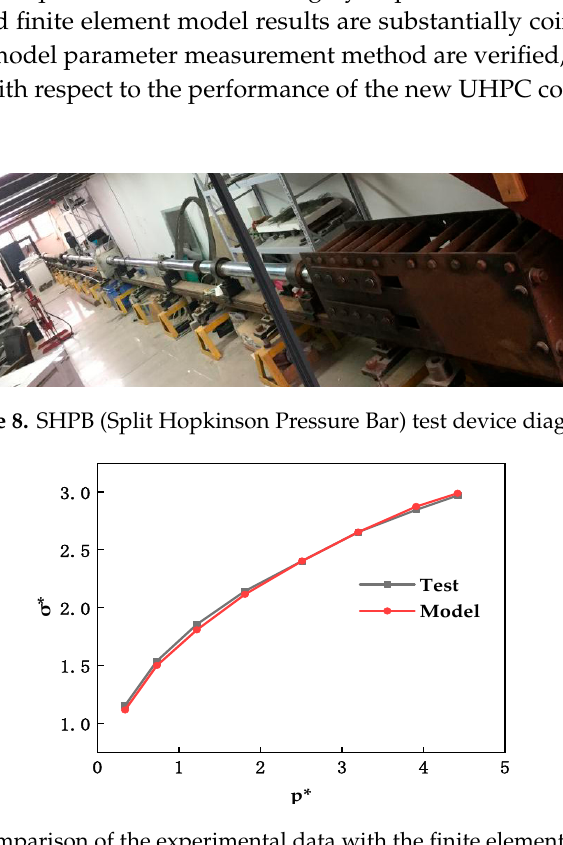
Figure 9. Comparison of the experimental data with the finite element simulation.